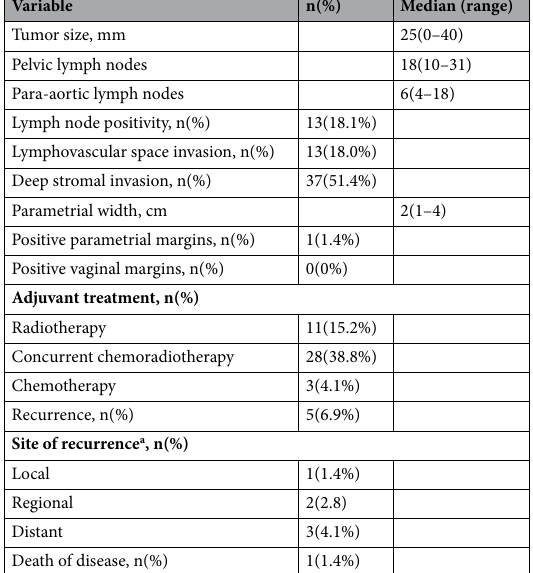
Table 4. Histological risk factors of the patients and the adjuvant therapy received (no. of surgery = 72). SPSS 17.0 (IBM Corp, Armonk, NY, USA) was used for statistical analysis.The website of SPSS is https:// www. ibm.